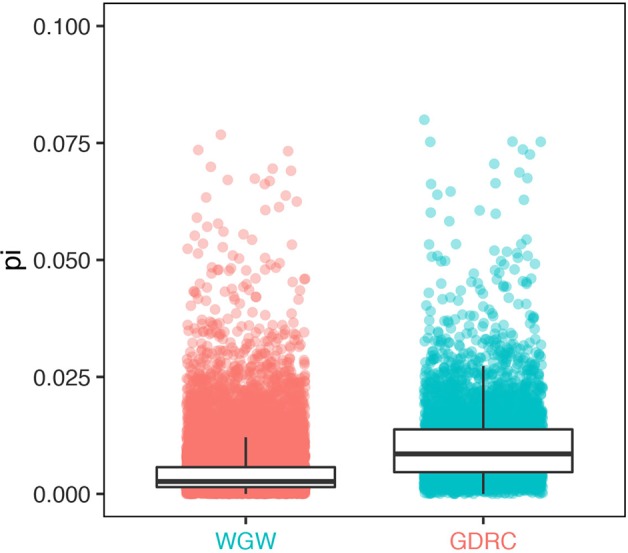
Sequence diversity of genes with significantly different read counts (GDRC) versus the whole-genome-wide (WGW) background.